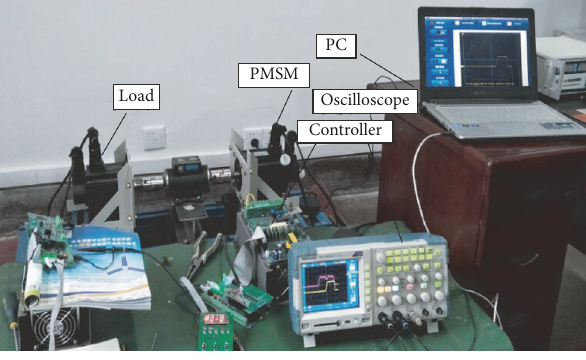
Figure 5: Load torque